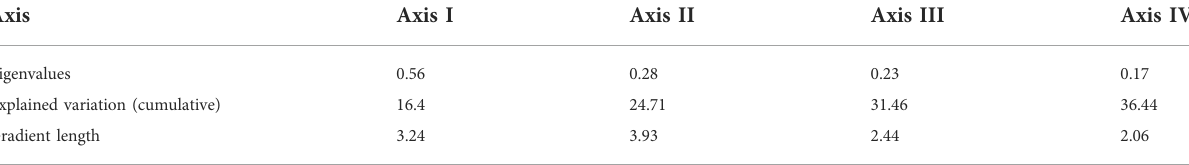
TABLE 2 The DCA analysis of the species variance of sandy alpine grassland communities.